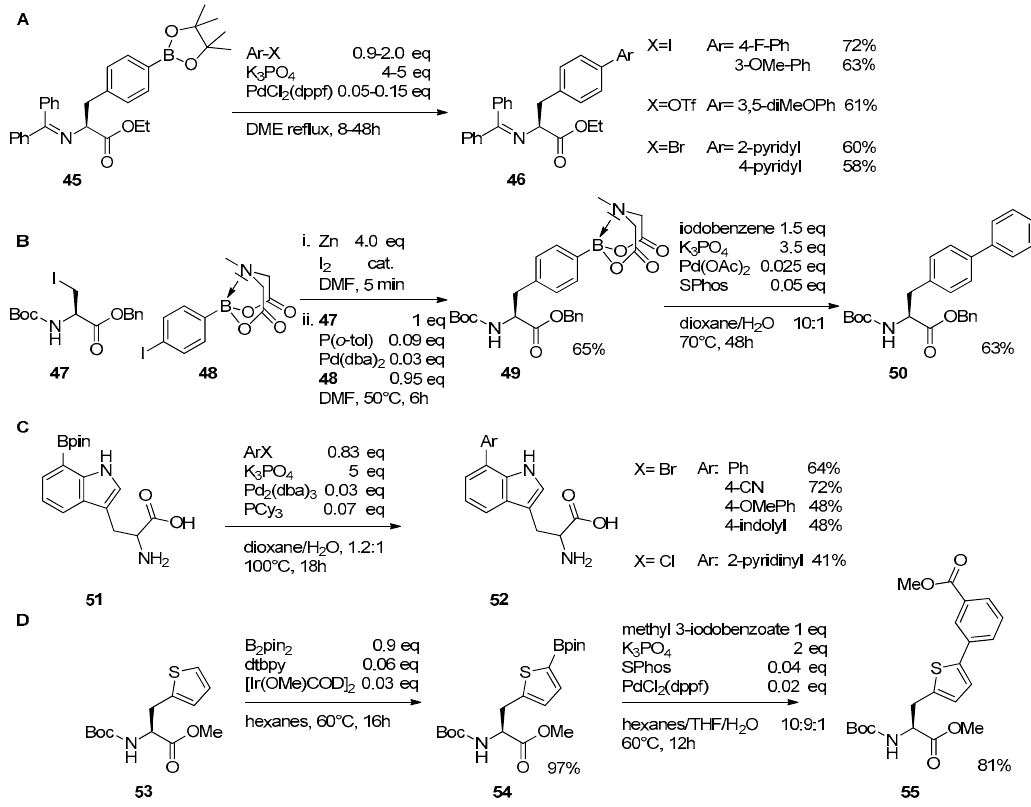
Figure 9. ( A ) Derivatization of N -benzophenone protected pinacolboronophenylalanine 45 with aryl